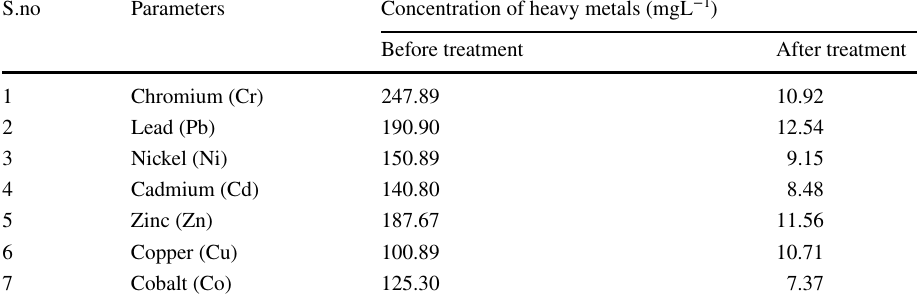
metals from Chlorella sp. after tannery effluent